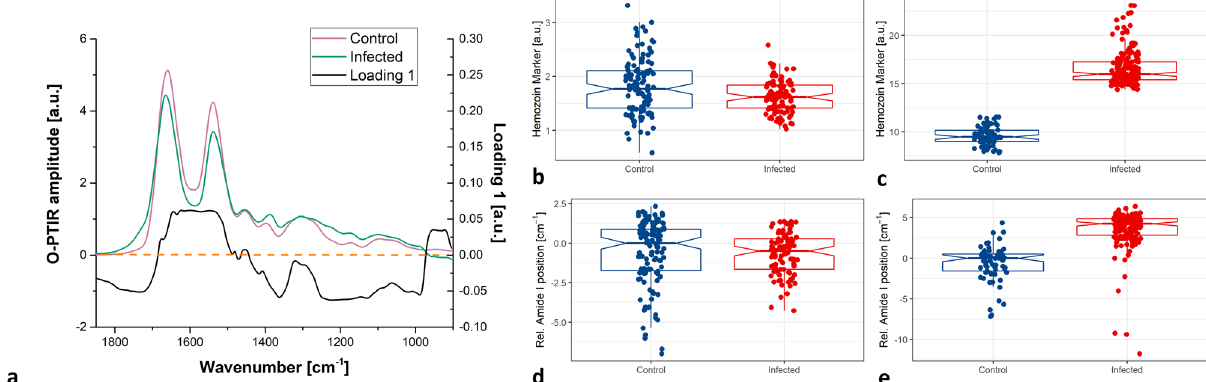
Fig. 4 Detailed analysis of spectra collected for control and infected RBCs by FTIR microspectroscopy and O-PTIR spectroscopy. Comparison of the O-PTIR mean spectra collected for control and infected RBCs with PC1 loading ( a ). Boxplots of area calculated under the spectrum line within the region 1720 – 1708 cm − 1 for each spectrum collected for control and infected RBCs by means of FTIR microspectroscopy ( b ) and O-PTIR ( c ). Boxplots of the relative positions of the amide I bands in single spectra collected for control and infected RBCs by means of FTIR microspectroscopy ( d ) and O-PTIR ( e ). The lower and upper hinges of the boxplots correspond to the fi rst and third quartiles, middle line to the median value. The whiskers extend from the hinge to the 1.5 * IQR (the distance between the fi rst and third quartiles). The notches extend 1.58 * IQR / sqrt(n), this gives a roughly 95% con fi dence interval for comparing